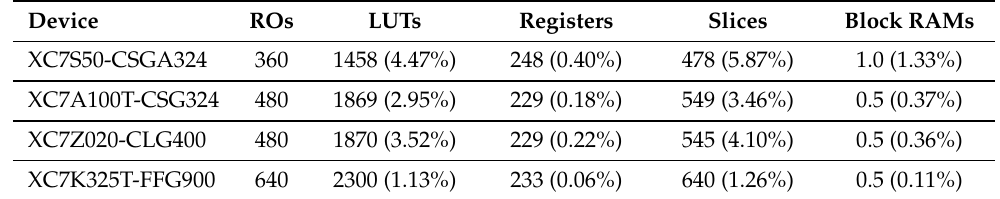
Table 1. Resource utilization of PUF/TRNG cores in Spartan-7, Artix-7, Zynq-7000, and Kintex-7 devices with 14-bit counters and different number of ROs.